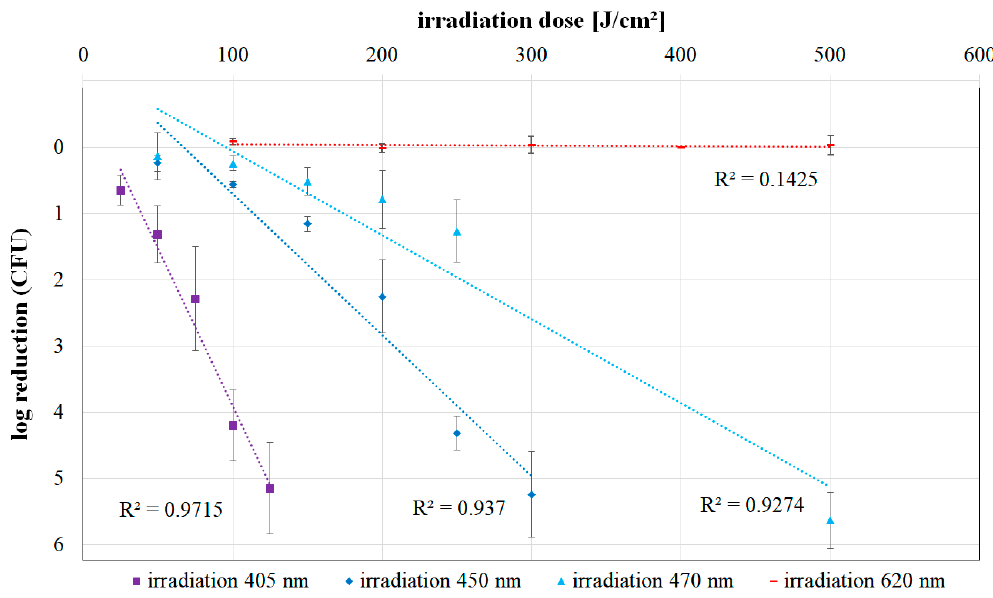
Figure 2. Log reduction of Legionella rubrilucens (DSM No. 11884) for increasing doses of 405 [23], 450, 470, and 620 nm irradiation. The values are given with the standard deviation for three independent individual runs per irradiation dose. In addition, a trend line of the values and the coefficient of determination R 2 were created for each wavelength.